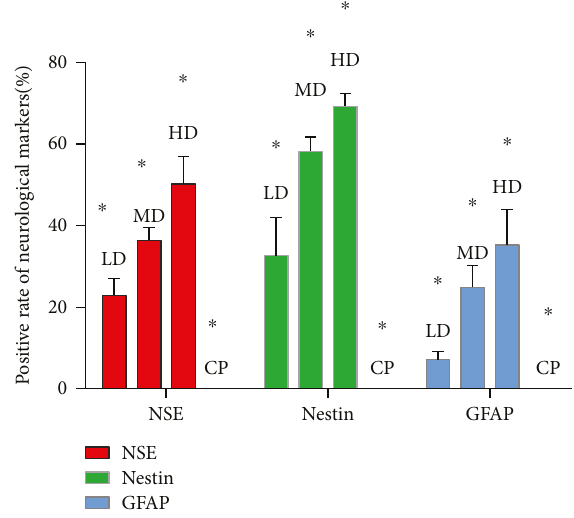
Figure 6: After 12 hours of induction, the positive rate of neuronal markers in each